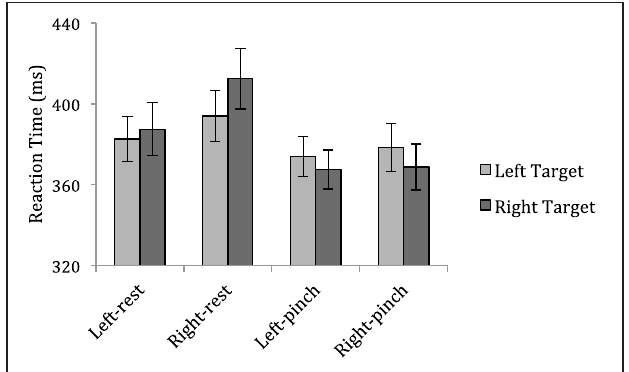
FIGURE 3 | Mean reaction times to detect targets in Experiment